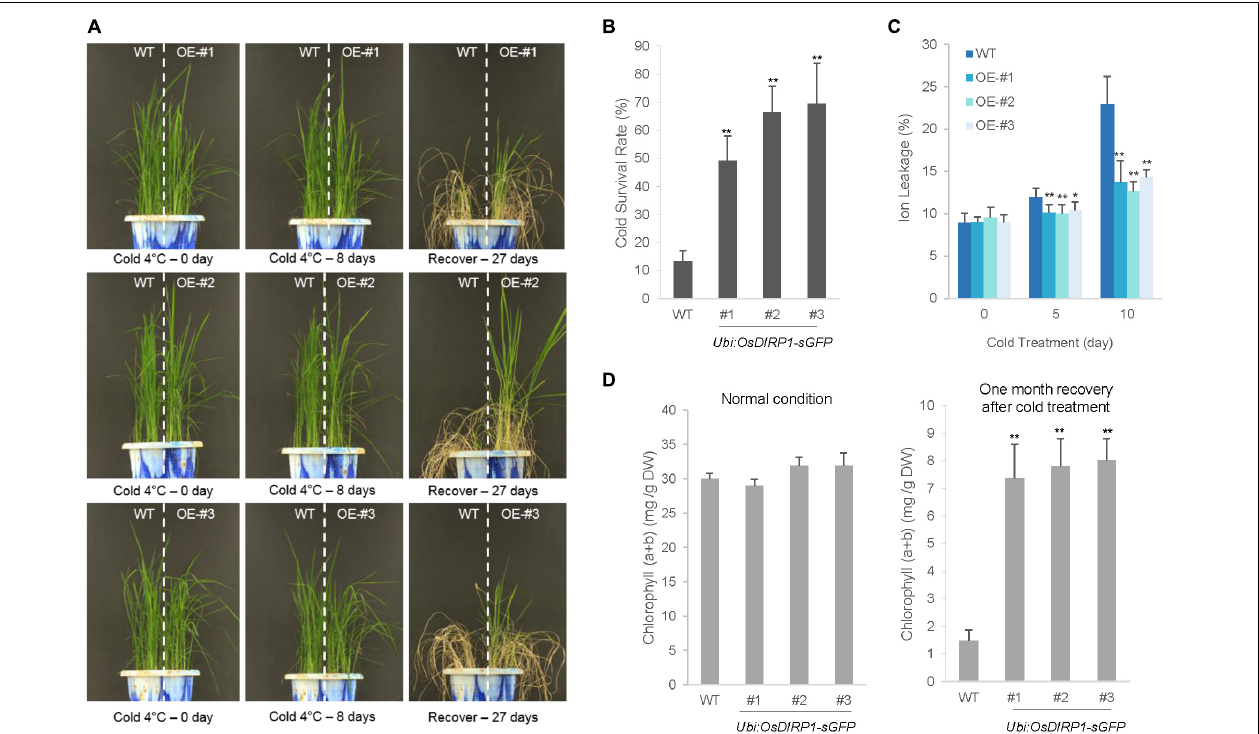
FIGURE 6 | Increased tolerance of Ubi:OsDIRP1-sGFP transgenic rice plants to cold stress. (A) Cold stress phenotypes of wild-type and T4 Ubi:OsDIRP1-sGFP transgenic plants. Light-grown, 5-week-old wild-type and T4 Ubi:OsDIRP1-sGFP (lines #1, #2, and #3) plants were transferred to a cold room at 4 ◦ C for 8 days, after which the plants were recovered at 28 ◦ C for 27 days. OE represents OsDIRP1- overexpressing transgenic plants. (B) Survival rates of wild-type (WT) and T4 Ubi:OsDIRP1-sGFP plants in response to cold stress. Data are means ± SE ( n ≥ 6 independent biological experiments; > 30 plants were used in each assay, ∗∗ P < 0.01, Student’s t -test). (C) Electrolyte leakage analysis of wild-type (WT) and T4 Ubi:OsDIRP1-sGFP plants in response to cold stress. Electrolyte leakage analysis was conducted using 8-day-old wild-type and transgenic seedlings at different time points before and after cold (4 ◦ C) treatment (0, 5, and 10 days). Data are means ± SD ( n = 3 independent biological experiments; 12 plants of each genotype were used in each experiment, ∗ P < 0.05, ∗∗ P < 0.01, Student’s t -test). (D) Total leaf chlorophyll content of wild-type and T4 Ubi:OsDIRP1-sGFP (lines #1, #2, and #3) transgenic rice plants before and after cold treatment. The amounts of leaf chlorophyll (chlorophyll a + chlorophyll b) of mock-treated (before cold) and cold-treated plants were determined 1 month after recovery from cold stress. Data are means ± SE ( n ≥ 3 biological independent experiments; 30 plants were used in each assay, ∗∗ P < 0.01, Student’s t